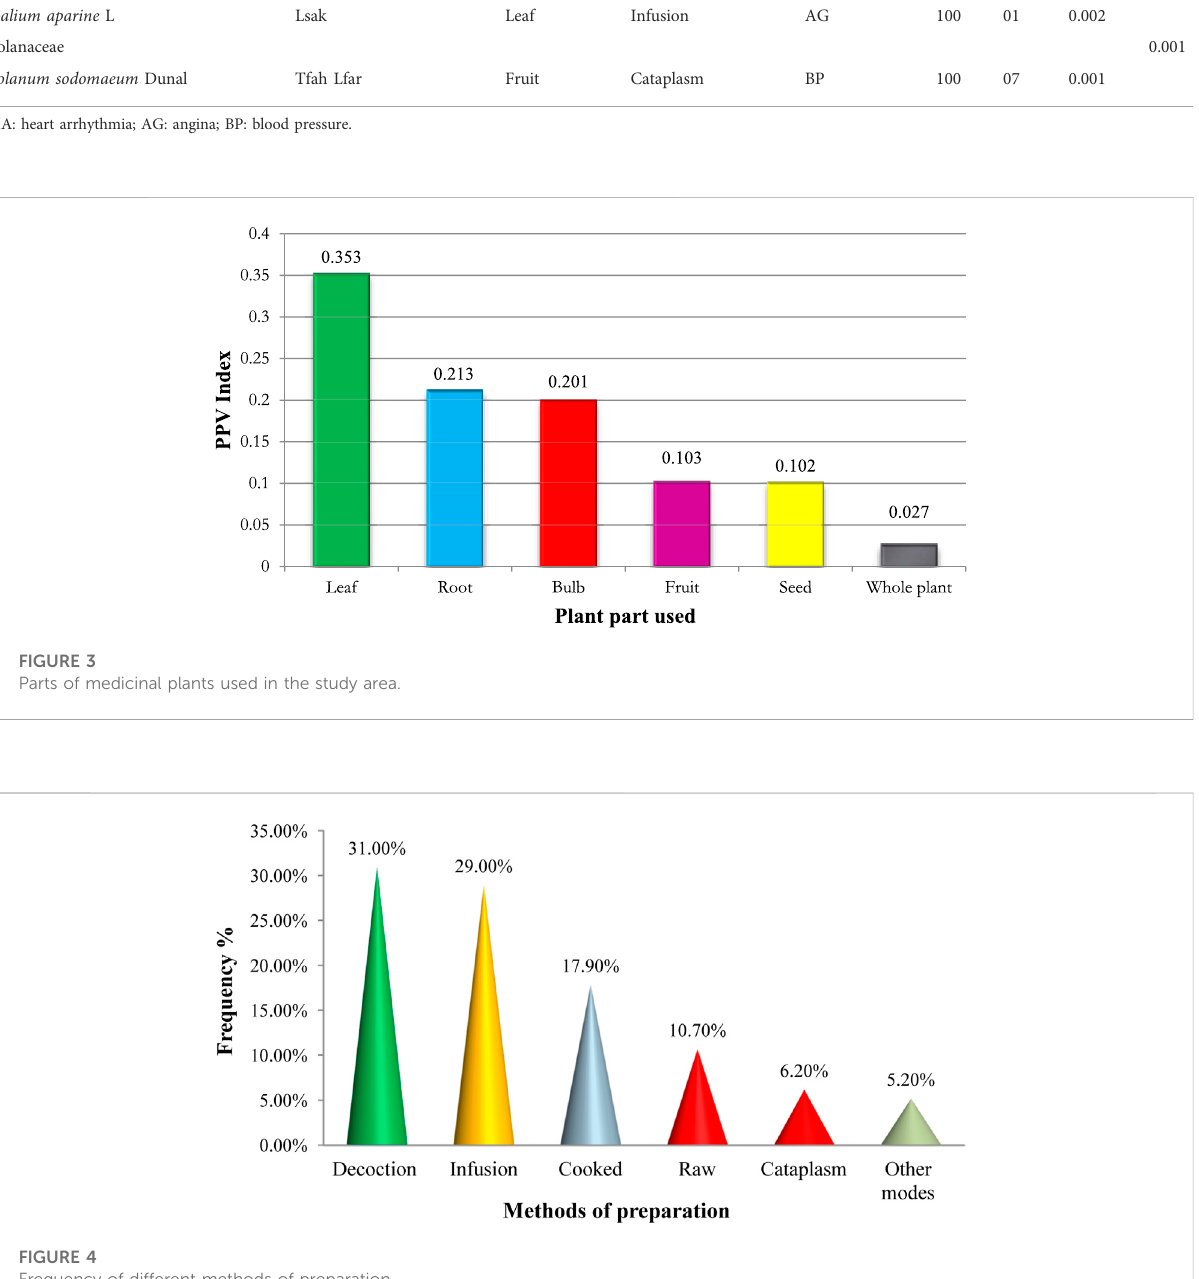
FIGURE 4 Frequency of different methods of